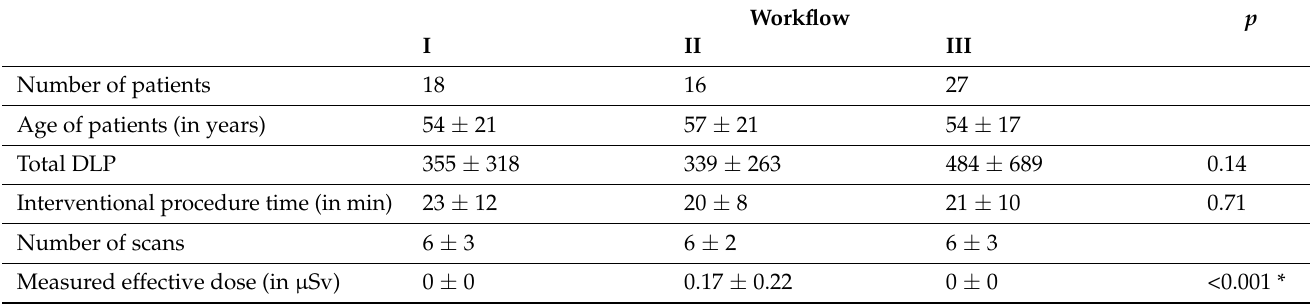
Table 1. Demographic details and study results. Workflows: The radiologist—(I) leaving the CT room during scanning; (II) wearing a lead apron and staying in the CT room; (III) staying in the CT room in a prototype radiation protection cabin without lead apron while utilizing a wireless remote control and a tablet. Numbers are given as mean ± standard deviation. A p -value < 0.05 was considered statistically significant and marked with an